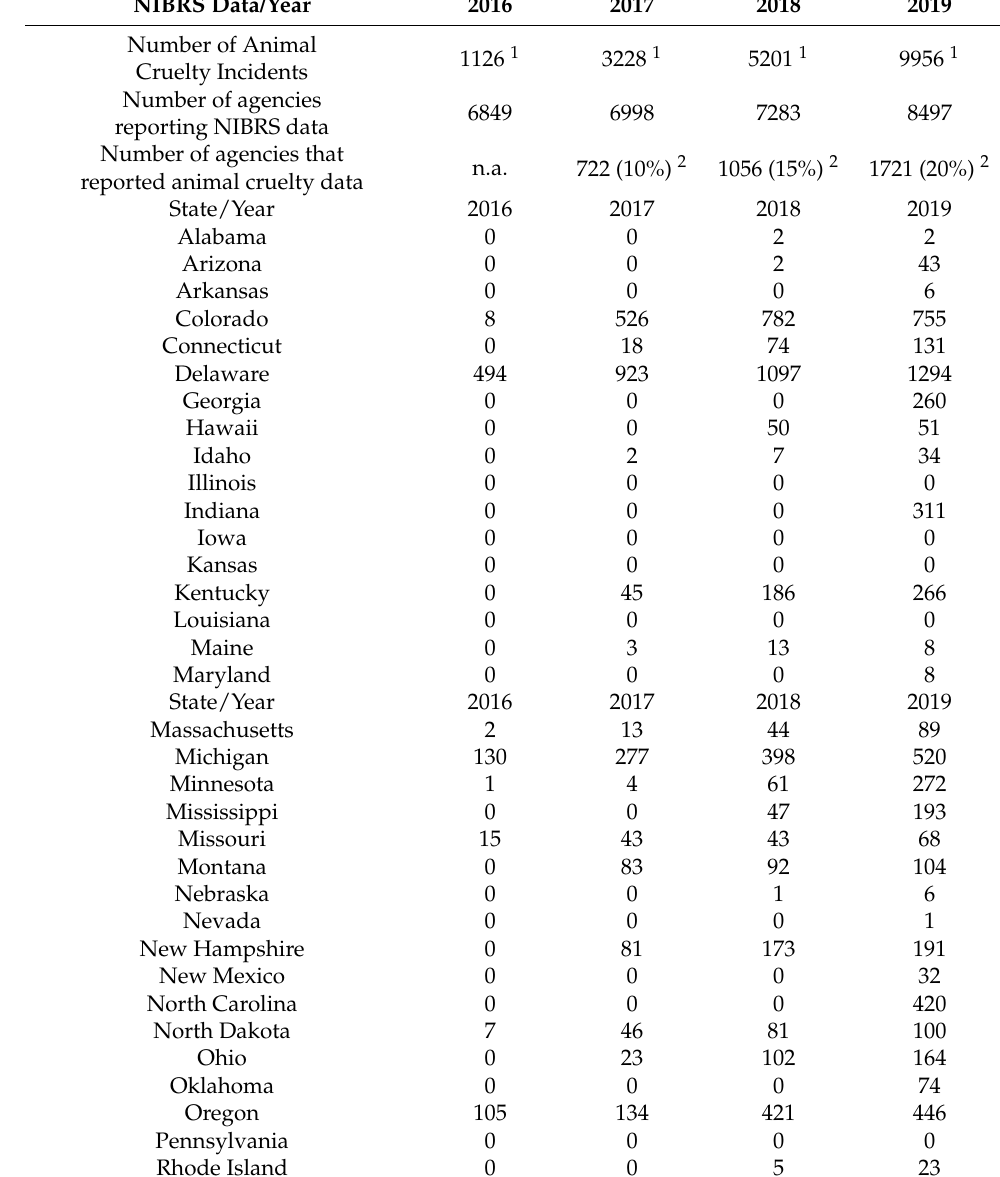
Table 1. Number of Animal Cruelty Incidents by State * for 2016–2019 from the FBI NIBRS website for each